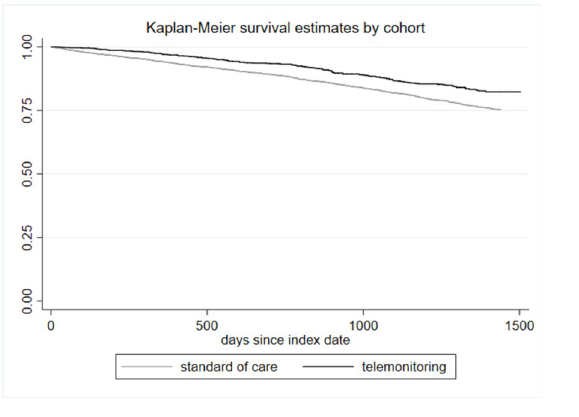
Fig 2. Kaplan-Meier survival estimates.